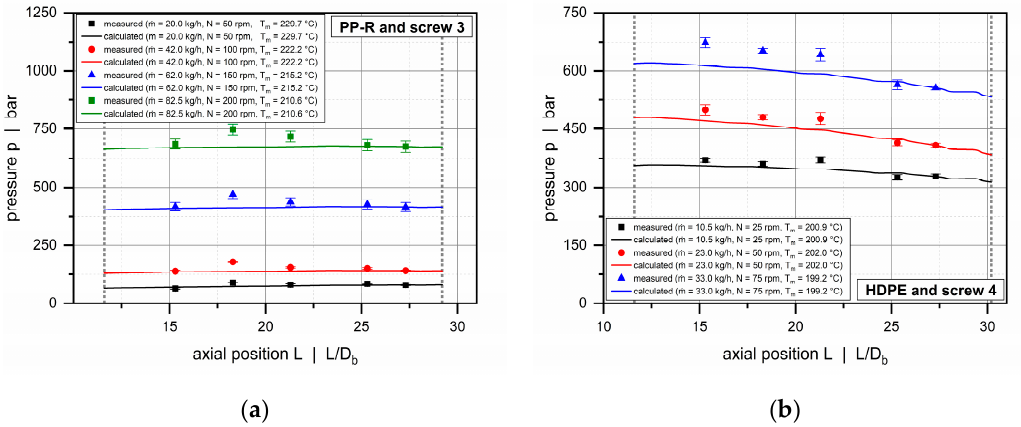
Figure 15. Comparison between experimental and calculated data for barrel 2. Axial pressure profiles along the wave zone for PP-R and screw 3 ( a ) and HDPE and screw 4 ( b ).